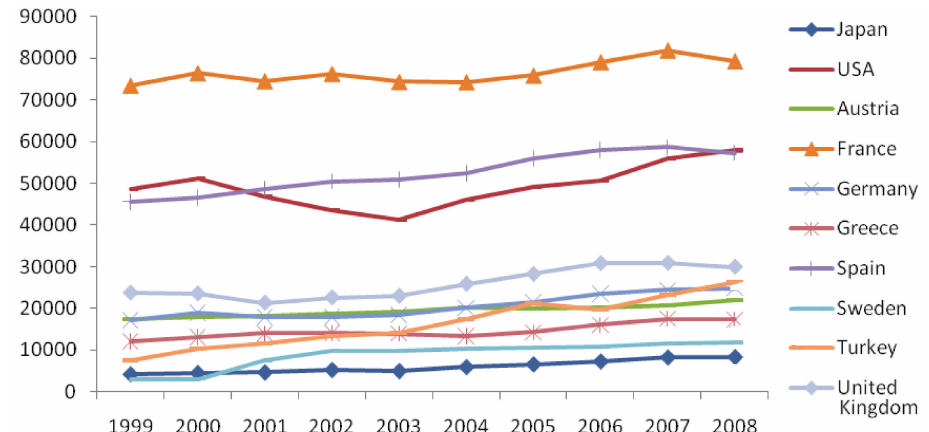
figure 1. number of international tourists inbound - selected oeCD countries - ‘000